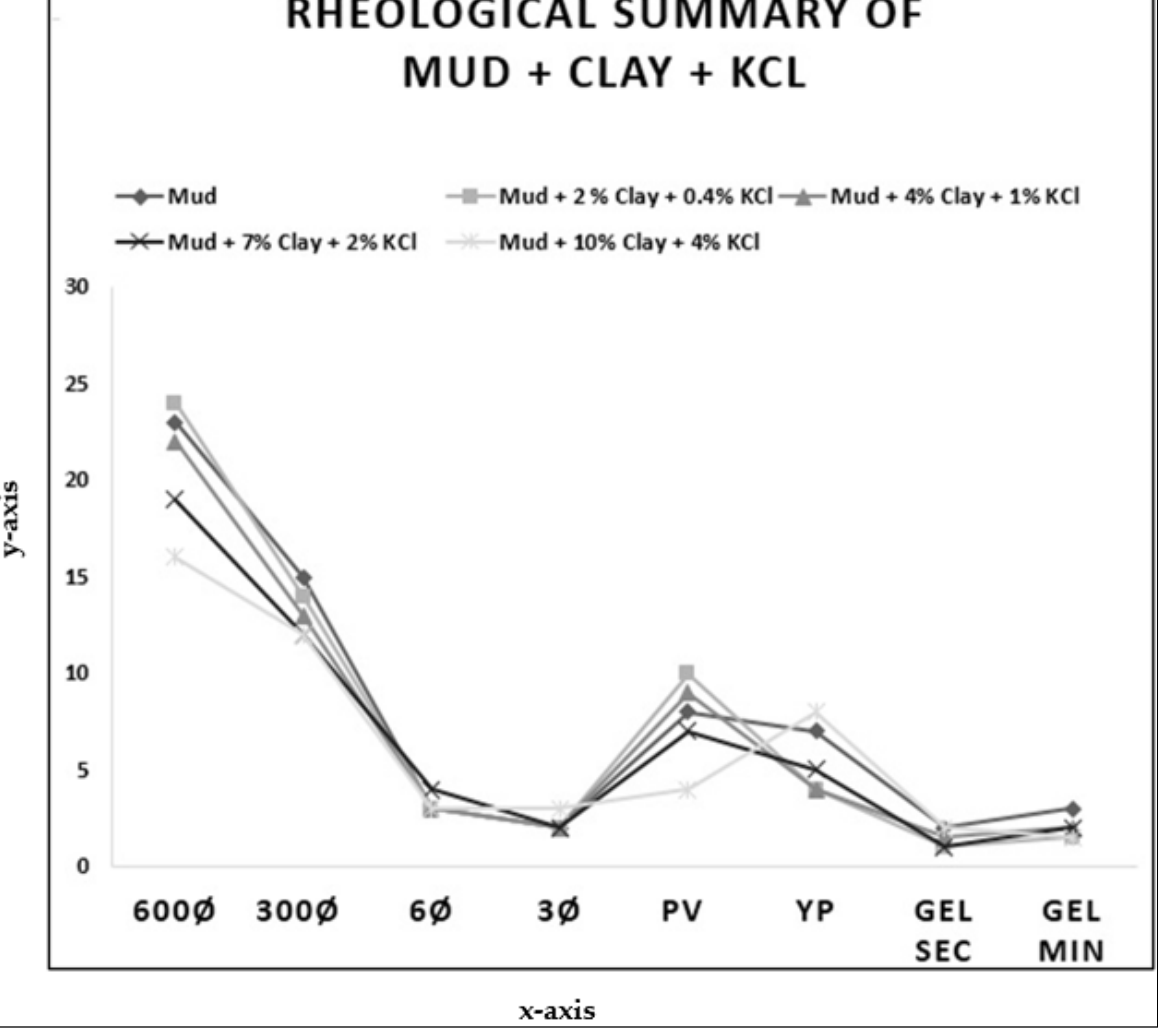
Figure 10. Trend correlation between default mud and mud + clay + KCL formulated mud. The rheological values are plotted along the y -axis and the rheological properties are mentioned along x -axis.